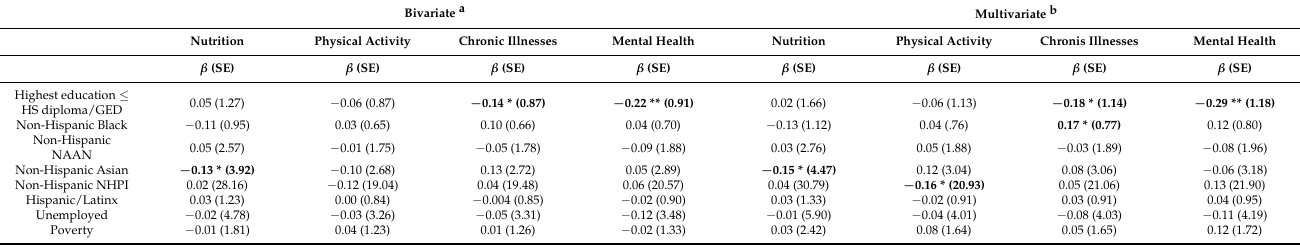
Table 5. Results of Bivariate and Multivariate Linear Regressions of the Relationship between Census Tract Demographics and Health-Related Programs Offered at Libraries in Census